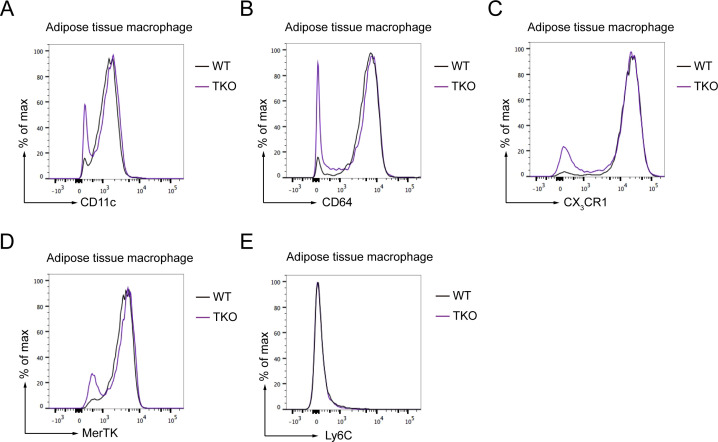
The adipose tissue macrophage (ATM) populations are not changed in TKO mice.(A–E) Flow cytometry analysis of CD11c (A), CD64 (B), CX3CR1 (C), MerTK (D), and Ly6C (E) expression in ATMs from Lyz2-Cre (WT) and TKO mice. Data are representative of two independent experiments.